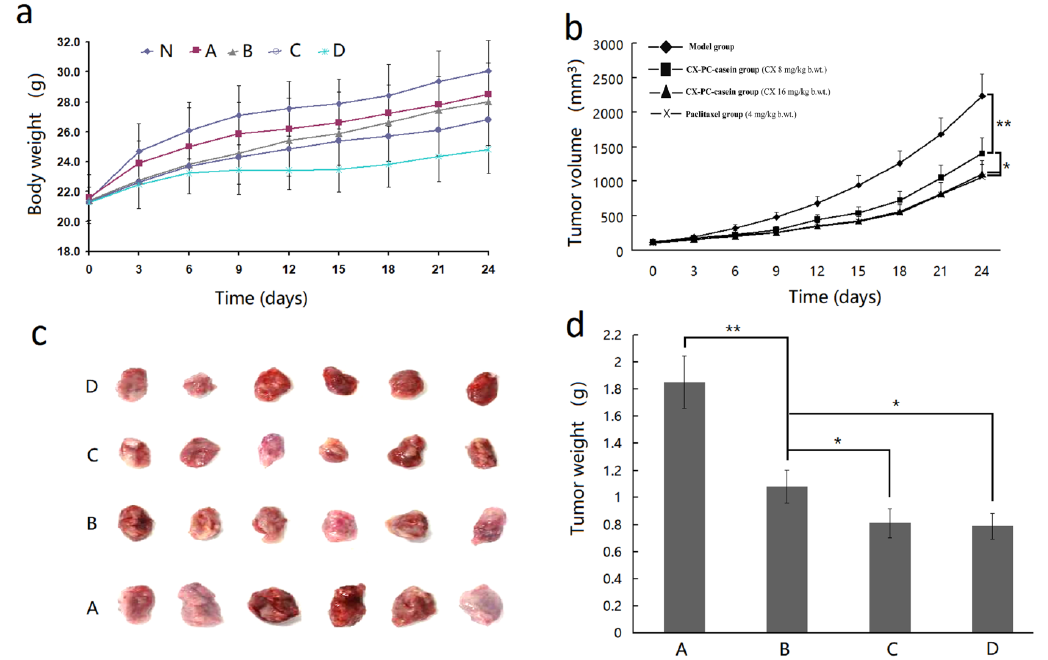
Figure 6. Results of animal experiments with different drug treatments. ( a ) Bodyweight changes, (N) Normal group, (A) model group, (B) CX-PC-casein nanoparticle group (CX 8 mg/kg b.wt.), (C) CX-PC-casein group (CX 16 mg/kg b.wt.), and (D) paclitaxel group (4 mg/kg b.wt.); ( b ) changes in tumor volume; ( c ) tumors after the final drug treatment; ( d ) tumor weight after the final drug treatment. * P < 0.05, ** P < 0.01.